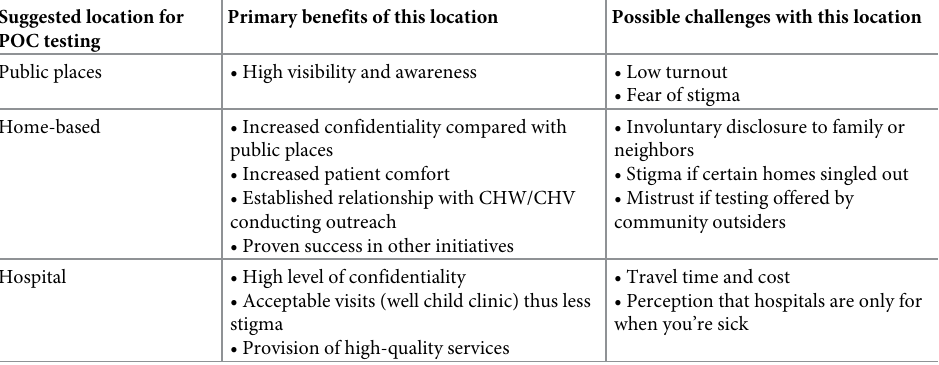
Table 2. Perceived benefits and barriers of various testing